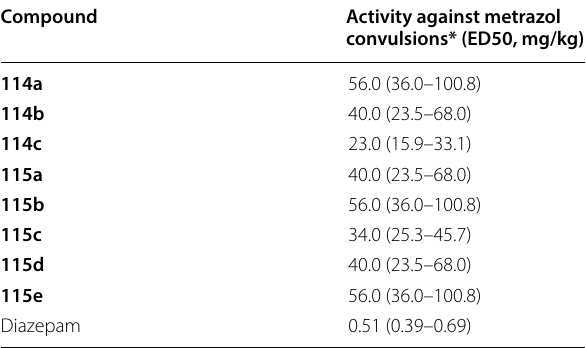
Table 26 Percentage efficiency of Clot lysis of synthetic compounds